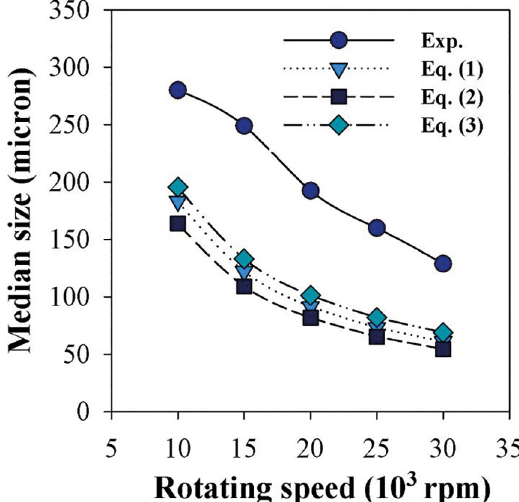
Figure 3. Effect of rotation speed on mass based median particle size, with 40 mm diameter flat disc, 50 kg/hr melt feed rate, and 550 o C melt temperature.